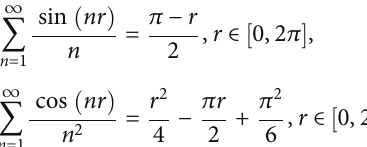
Figure 4: This fi gure shows the oscillation ρ ð r , t Þ = ∑ n =40 t = 0 in the range r ∈ ð 0, 2 π Þ . With A ð n Þ = 1/ nk ′ , k ′ = 1 , c superimposed. This fi gure can be used to compare with the single spherical standing wave model in Figure